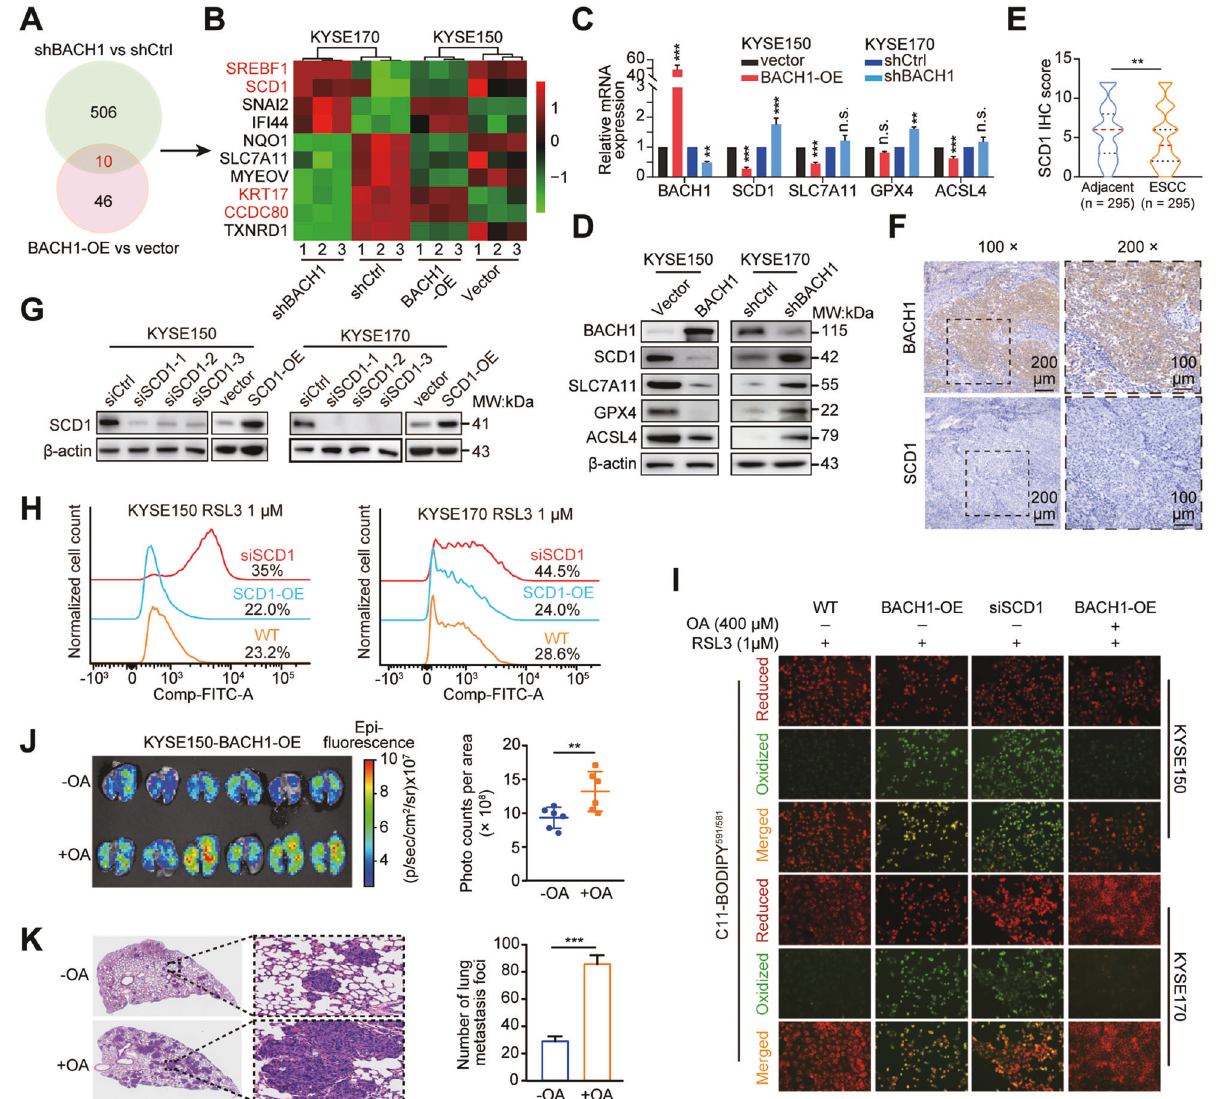
Fig. 6 BACH1 inhibits OA synthesis by negatively regulating SCD1. A Venn diagram showing overlapping 10 differentially expressed genes between two comparisons, KYSE170-shBACH1 vs. shCtrl (516 genes) and KYSE150-BACH1-OE vs. vector (56 genes), based on RNA sequencing. B Heatmap showing the expression of 10 common genes in the three biological replicates of the indicated RNA sequencing data. C, D RT – qPCR ( C ) and western blot ( D ) assays validated the mRNA and protein expression of SCD1, SLC7A11, GPX4 and ACSL4 after overexpression or knockdown of BACH1 in KYSE150 and KYSE170 cells. E Comparison of the immunohistochemical (IHC) scores of SCD1 in 295 ESCC and paired adjacent nontumor tissues by the Wilcoxon signed rank test. F Representative images of BACH1 and SCD1 expression levels in serial sections are shown. 100× scale bar, 200 μ m; 200× scale bar, 100 μ m. G The ef fi ciency of SCD1 knockdown (siSCD1-1, siSCD1-2 and siSCD1-3) or overexpression (SCD1-OE) in KYSE150 and KYSE170 cells was determined by western blotting. H Flow cytometric analysis after C11-BODIPY 591/581 staining indicating the lipid peroxidation levels in KYSE150 and KYSE170 cells that were transiently transfected with SCD1 overexpression plasmid or siRNA oligos followed by treatment with 1 μ M RSL3. I Lipid peroxidation was stained and visualized with the fl uorescent probe C11-BODIPY 591/581 . KYSE150 and KYSE170 cells were transiently transfected with the BACH1 overexpression plasmid or siRNA oligos of SCD1 and then incubated with 1 μ M RSL3 alone or RSL3 combined with 400 μ M OA. Red and green fl uorescence signals show normal lipids (reduced C11-BODIPY) and peroxidative lipids (oxidized C11-BODIPY), respectively. J Bioluminescence imaging (left panel) and quanti fi cation of photon fl ux (right panel) of lung metastatic tissues from NCG mice (n = 6 mice per group) with intravenous injection of KYSE150-BACH1-OE cells in the absence or presence of 400 μ M OA. OA addition markedly promoted the pulmonary metastasis of ESCC cells. K Representative hematoxylin and eosin (H&E) staining and quantitative analysis of lung metastatic foci of dissected lungs from the NCG mice in panel ( J ), showing that OA addition ( + OA) generated more and larger metastases than the control ferroptosis by replacing PUFAs in lipid membranes and reducing BACH1 inhibited OA synthesis through transcriptional repression the accumulation of lipid peroxidation products [24]. SCD1 has of SCD1. SCD1 is an endoplasmic reticulum-related enzyme been found to protect tumor cells from ferroptotic cell death in involved in the de novo synthesis of fatty acids by catalyzing the ovarian, lung and gastric cancers [48 – 50]. Thus, BACH1 affects the desaturation of saturated fatty acids, such as stearic acid(18:0) sensitivity of cells to ferroptosis by regulating the fatty acid and palmitic acid(16:0), to Δ 9 MUFAs, such as OA(18:1) and composition in cells, which results in cell preference to palmitoleic acid(16:1) [47]. MUFAs can effectively inhibit